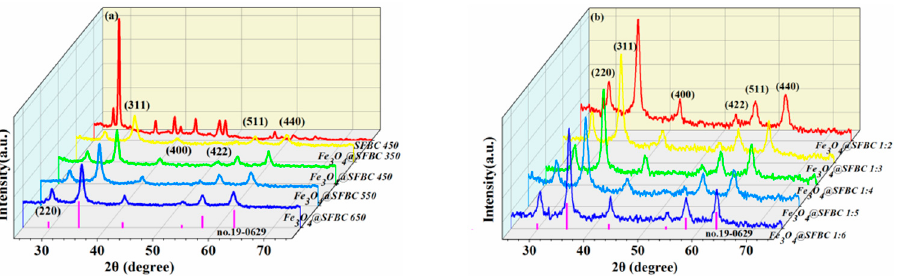
Figure 1. XRD spectra of Fe 3 O 4 nanomaterials prepared by biochar at different calcination tempera- tures ( a ) and XRD spectra of Fe 3 O 4 nanomaterials prepared by different SFBC/Fe mass ratios ( b